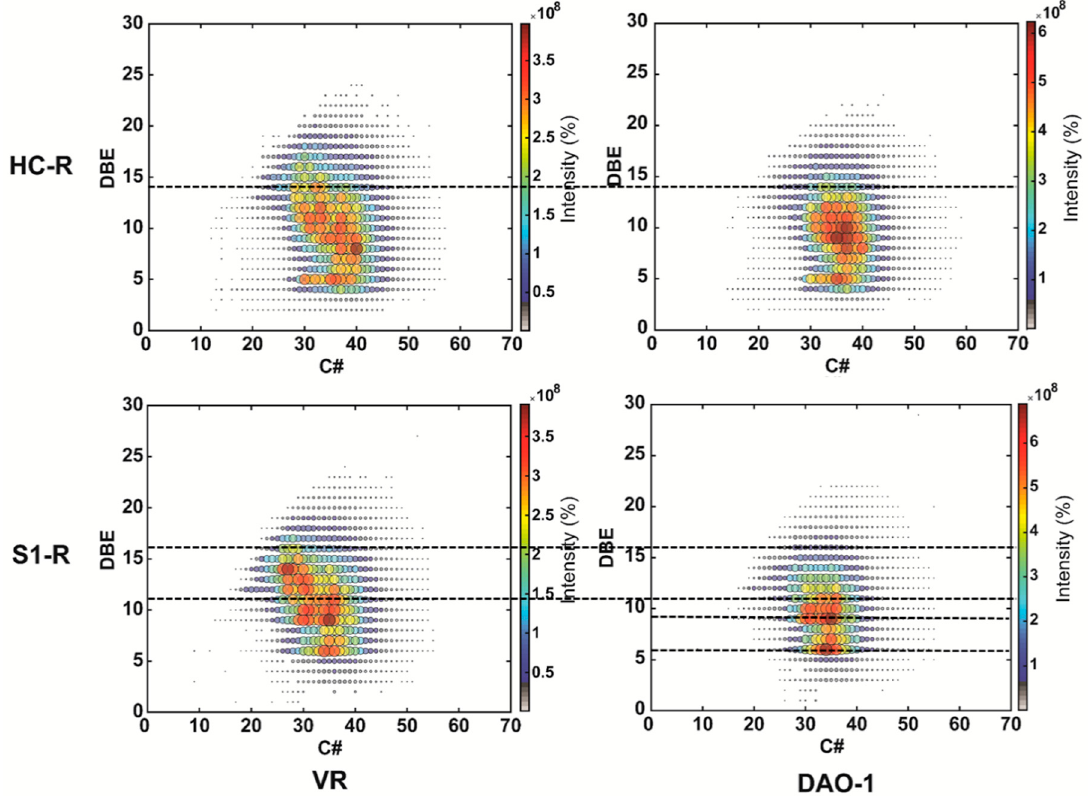
Figure 7. Double bond equivalent (DBE) / C# maps of the HC and S 1 chemical classes showing the cation radical species detected by the atmospheric pressure photo ionization (APPI) ± Fourier transformation ion cyclotron resonance (FT-ICR) mass spectra of VR (feed) and deasphalted oil (DAO) obtained from the SDA unit.